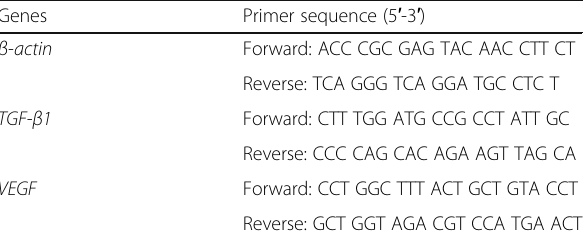
Table 1 Primer sequences of target genes in the rat model Genes Primer sequence (5 ′ -3 ′ )